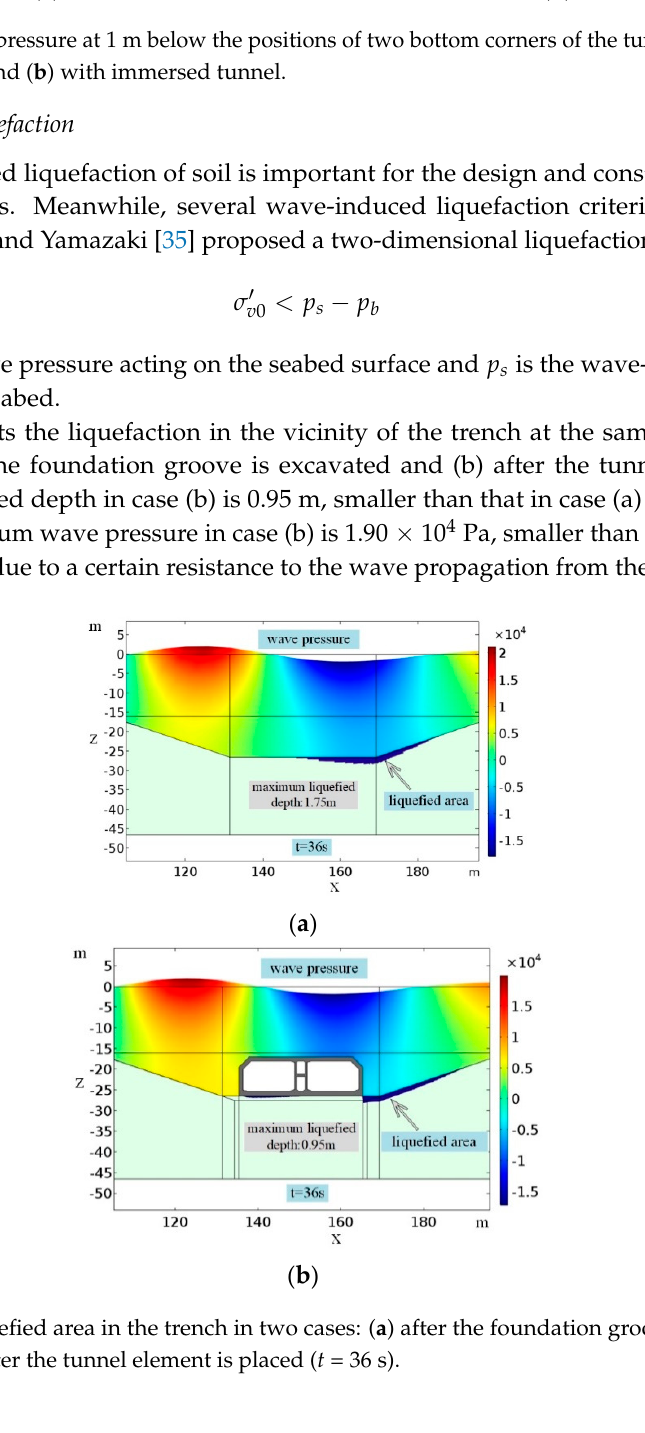
Figure 9. The pore pressure at 1 m below the positions of two bottom corners of the tunnel: ( a ) without immersed tunnel and ( b ) with immersed tunnel.